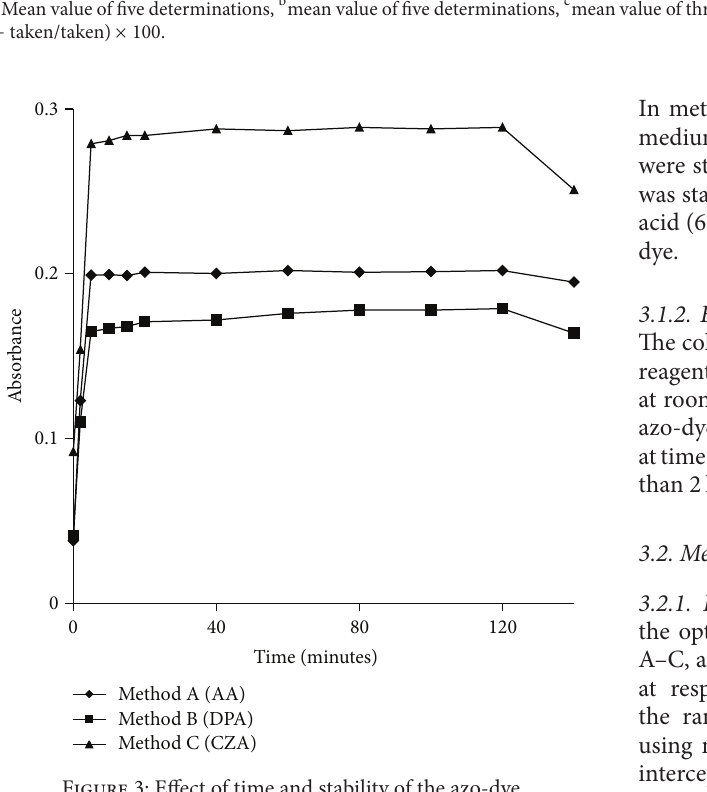
(DPA) for method B, and aqueous citrazinic acid